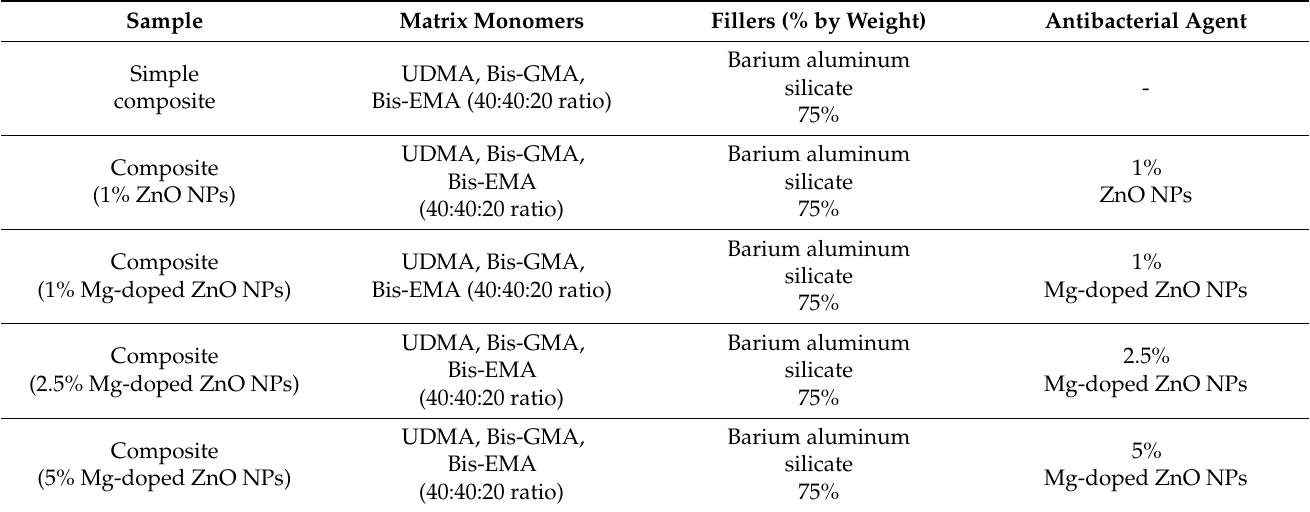
Table 3. Chemical composition of experimental